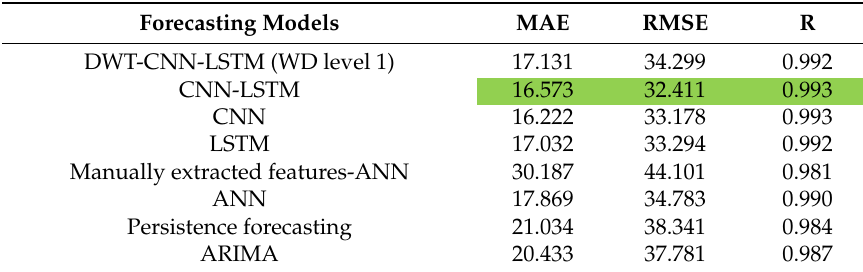
Table 9. The performance comparison of different sunny day’s forecasting models using the dataset of Desert Rock